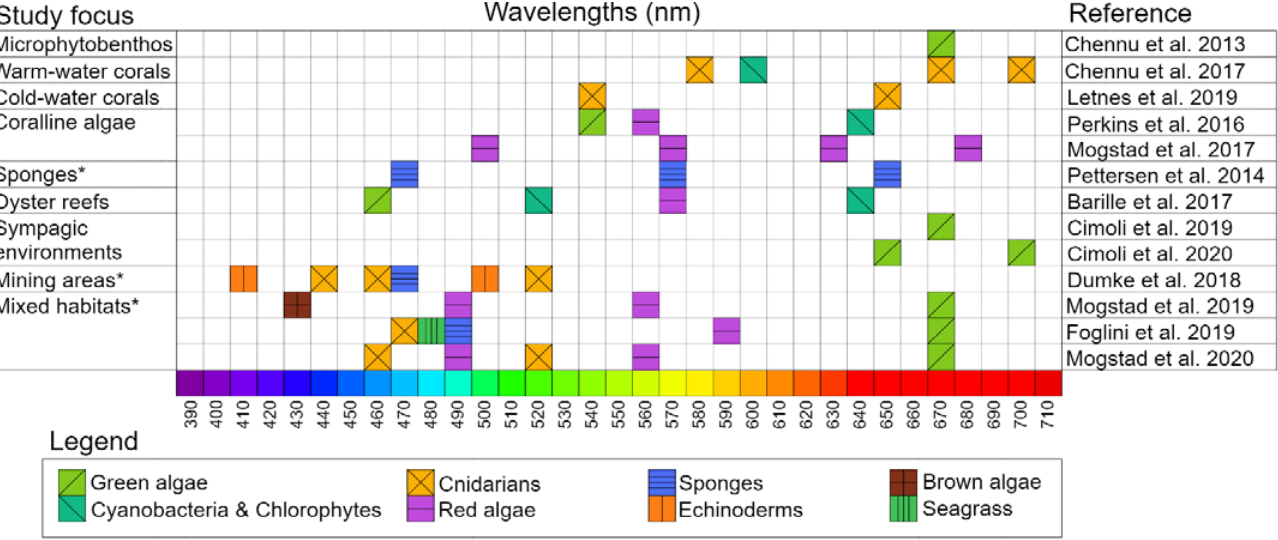
Figure 5. A summary of studies using UHI focusing on marine environments or organisms (left column). The bands shown on this figure have been employed for organism detection, or classification*, or estimation of pigment abundance. The different biota is indicated by different colours/patterns. Wavelengths were binned down to 10 nm intervals ranging from 390 to 710 nm. Presentation of binned wavelengths of pigment absorption was adapted from [57].